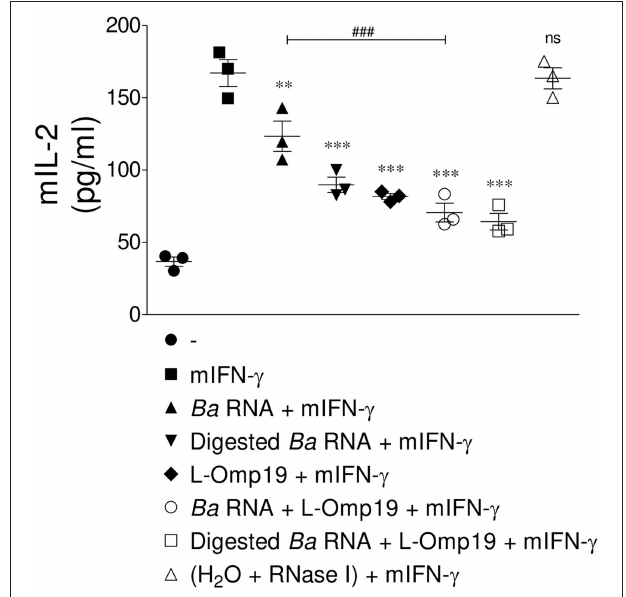
FIGURE 9 | MHC-II down-modulation correlates with diminished antigen presentation to CD4 + T cells. BMM were treated with B. abortus RNA (10 µ g/ml), digested B. abortus RNA, L-Omp19 (1 µ g/ml) or their combination in the presence of mIFN- γ for 48h. Then, cells were washed and incubated with 100 µ g/ml of OVA peptide for 3h at 37 ◦ C. Afterwards, cells were washed and co-cultured for 20h at 37 ◦ C with BO97.10 cells, a T cell hybridoma specific for OVA peptide. T cell activation was measured by quantifying mIL-2 secretion in culture supernatants. ** P < 0.01; *** P < 0.001 vs. mIFN- γ -treated cells; ns, non-significant; ### P < 0.001 vs. Ba